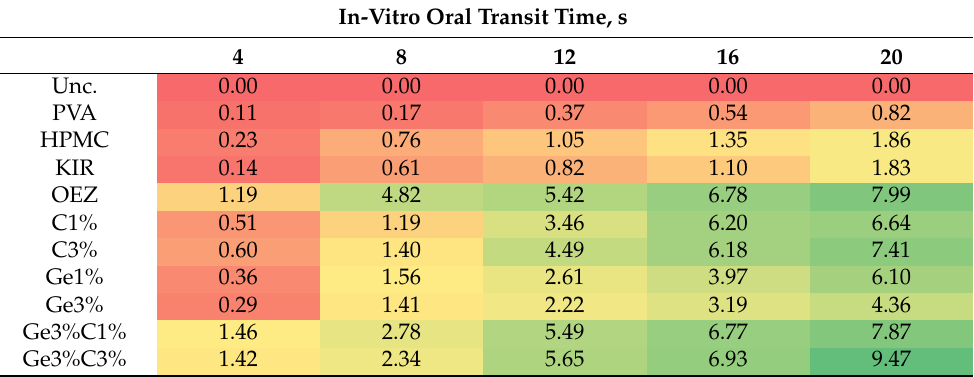
Table 3. Swallowability matrix of coated tablet formulations of sequential increasing complexity, as determined by the swallowability index ranked from poor (red), pass (orange), good (yellow), very good (lime green), to excellent (dark green).